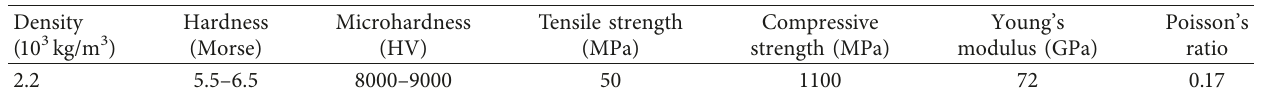
Figure 10: The measurement result of amplitude. (a) Amplitude horn 1. (b) Amplitude horn 2. (c) Amplitude horn 3. Table 4: Mechanical properties of quartz glass.